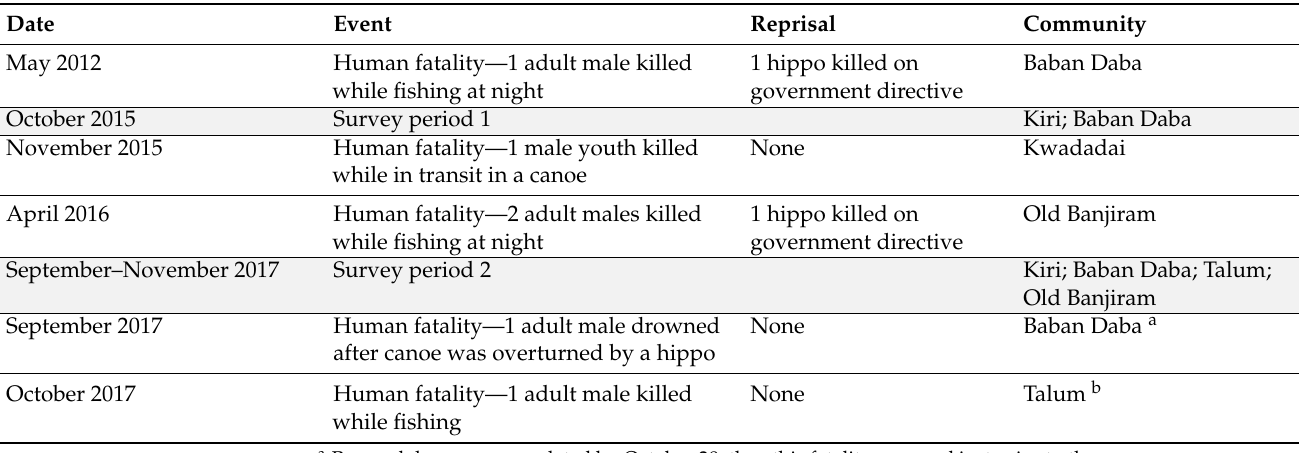
Table 1. Timeline of surveys, hippo-caused human fatalities, and reprisal action at Kiri Dam reservoir from 2012–2017. Although unverified officially, local reports indicate that other fatalities likely occurred between 1982 (when the dam was completed) and 2012; these reports did not appear in the government record. Since this study concluded, one fatality occurred at Baban Daba (August 2022). All fatalities occurred on